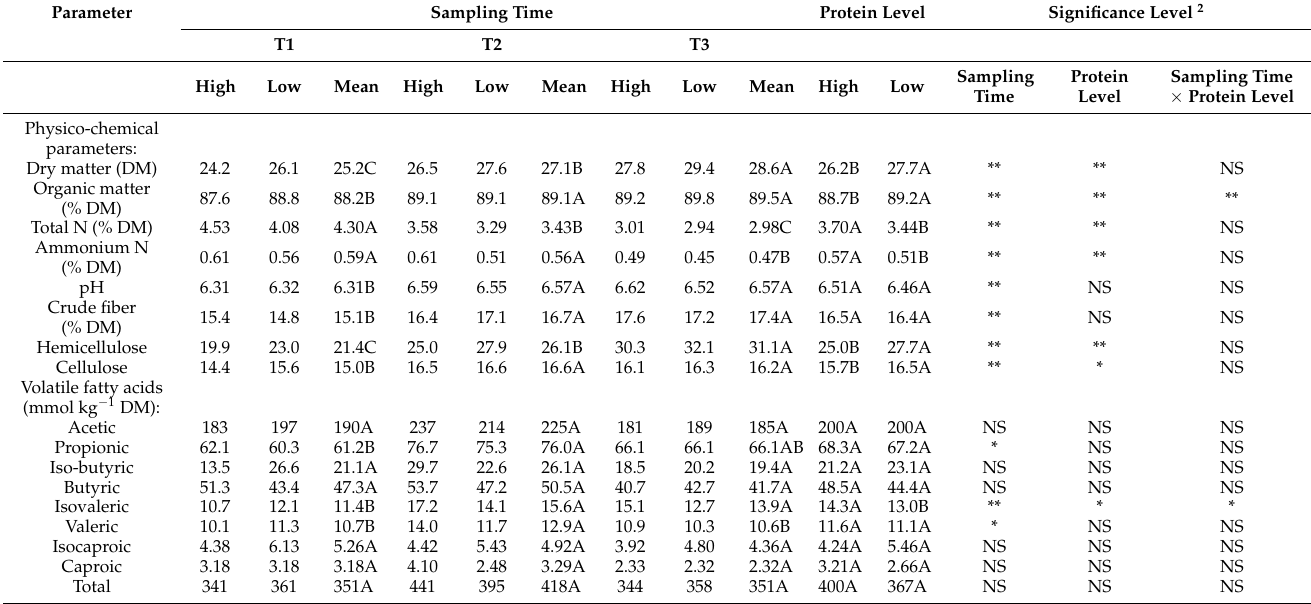
Table 9. Composition of the fecal samples depending on sampling time (T1, T2, and T3) and protein level in the diet 1